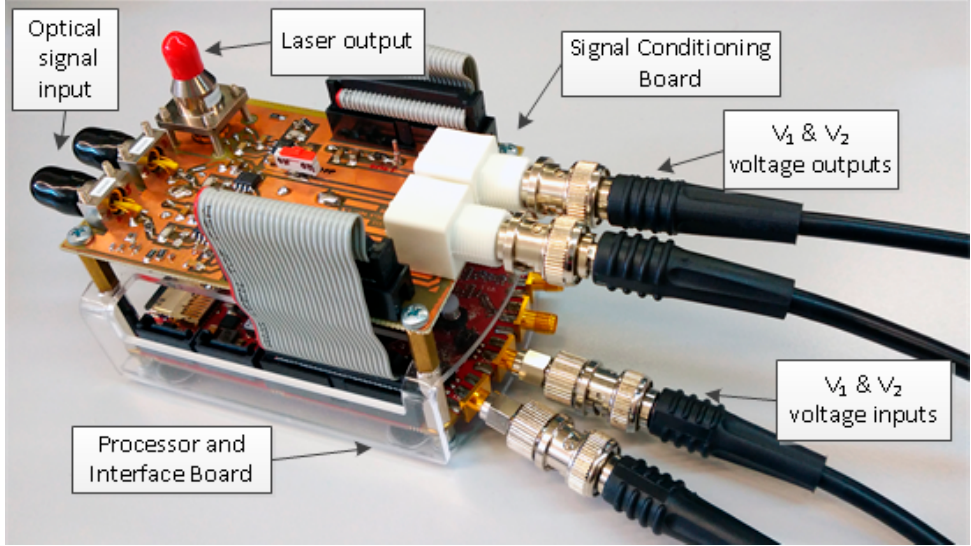
Figure 4. Electronic system to measure Tip Clearance (TC) and Time of Arrival (ToA).